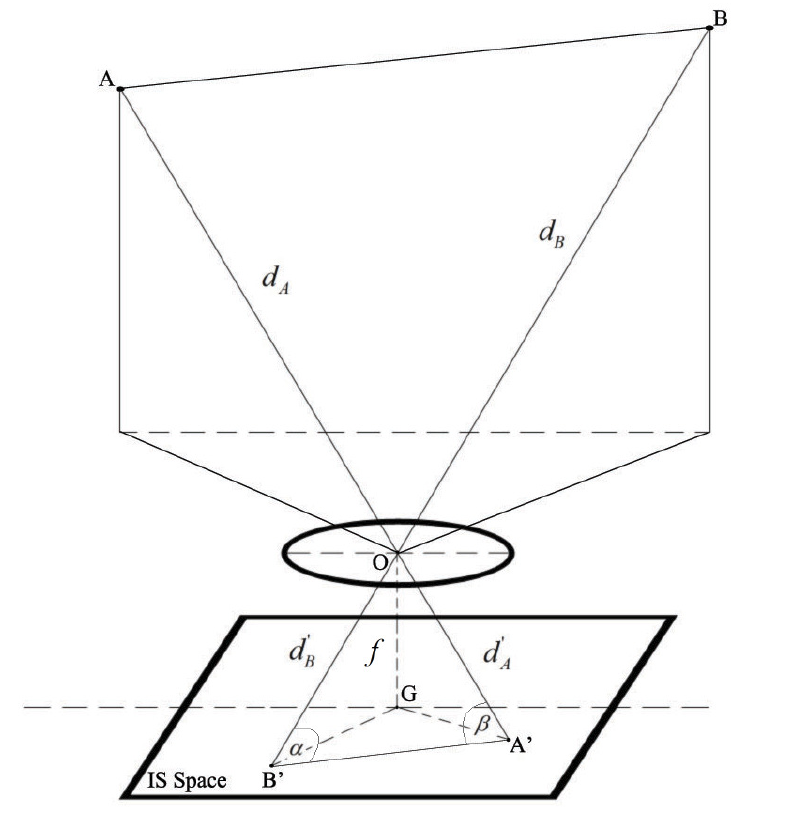
Figure 2. Positioning